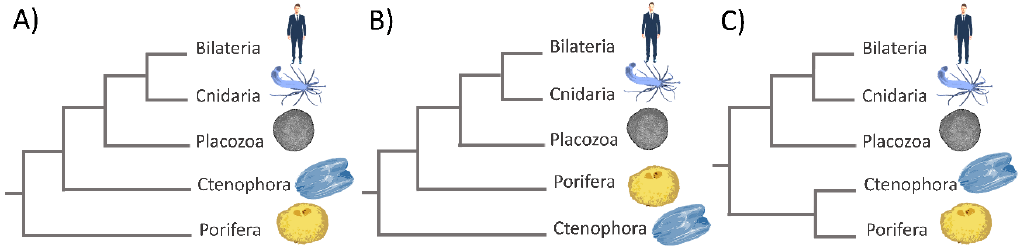
Figure 3. Phylogenetic relationships among non-bilaterian phyla and their relationship with Bilateria. ( A ) Porifera sister to all other metazoan; ( B ) Ctenophora sister to all other metazoan; ( C ) Porifera + Ctenophora clade sister to all other Metazoa.